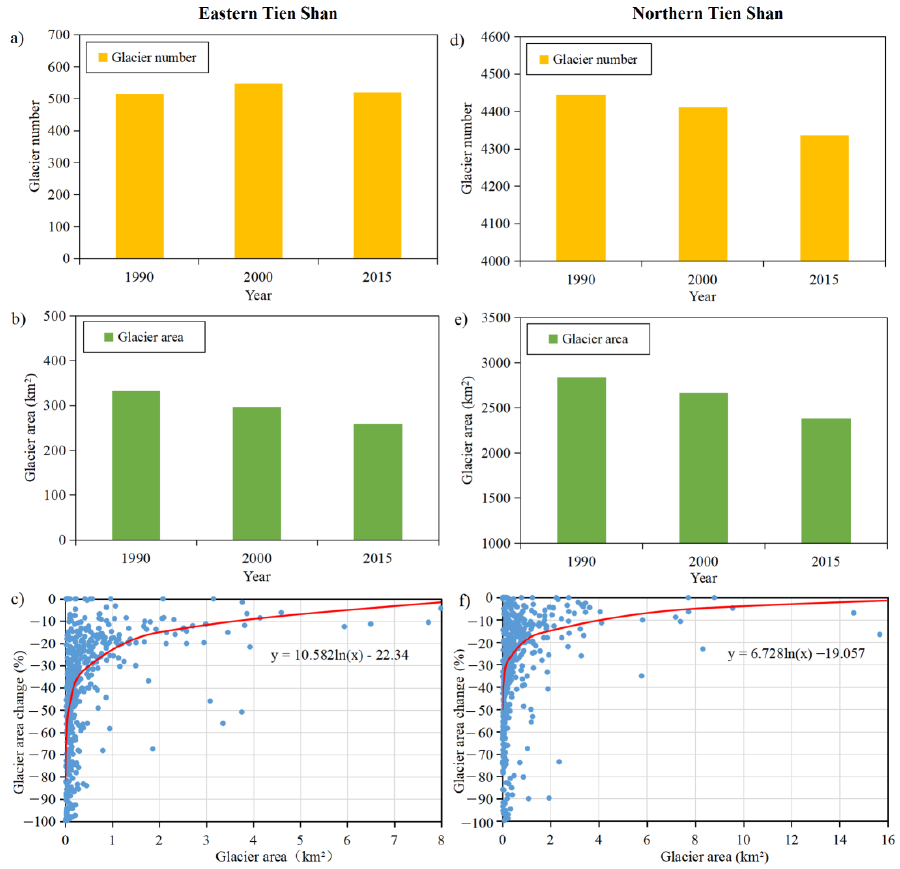
Figure 8. Changes in glacier number and area across the Eastern Tien Shan. ( a , d ) Glacier number; ( b , e ) glacier area; ( c , f ) change rates in glacier area for glaciers of different sizes. Two typical glaciers ’ (with a similar scale and elevation range) long-term monitoring records (the Ts. Tuyuksuyskiy glacier in the Western TS and Urumqi glacier No. 1 in the Northern TS) were analyzed (Figure 9). For both, the average annual and cumulative GMB was negative from 1980 to 2015; the cumulative GMB was 18,073 mm and 17,102 mm for the Tuyuksuyskiy glacier and Urumqi glacier No. 1, respectively. Compared to the West- ern TS, the GMB in Northern TS had the greatest loss. The annual average GMB change of Urumqi glacier No. 1 was about −15.70 mm/a, which was notably higher than that of the Western TS (which had a loss rate of −0.26 mm/a). The annual equilibrium-line altitude (ELA) of the Tuyuksuyskiy glacier rose by 0.30 m/a and possessed a change rate that was notably lower than that of Urumqi glacier No. 1, which changed at a rate of 13.16 m/a. For the Tuyuksuyskiy glacier, the annual average GMB was − 486.64 mm between 1990 and 2000 and slowed to − 463.31mm post-2000. The annual average GMB of Urumqi glacier No. 1 was − 362.55 mm between 1990 and 2000, which increased to − 652.25 mm during the 2000 – 2015 period.